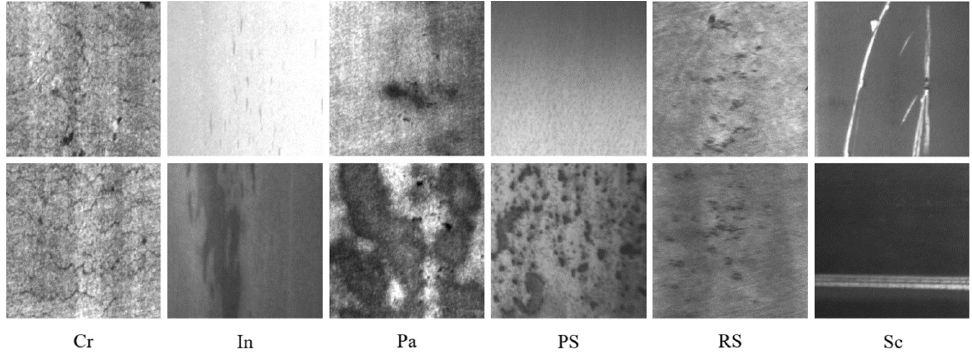
Figure 4. The examples of the NEU dataset, where Cr, In, Pa, PS, RS, and Sc denote the crazing, inclusion, patches, pitted surface, rolled-in scale, and scratches defects, respectively.